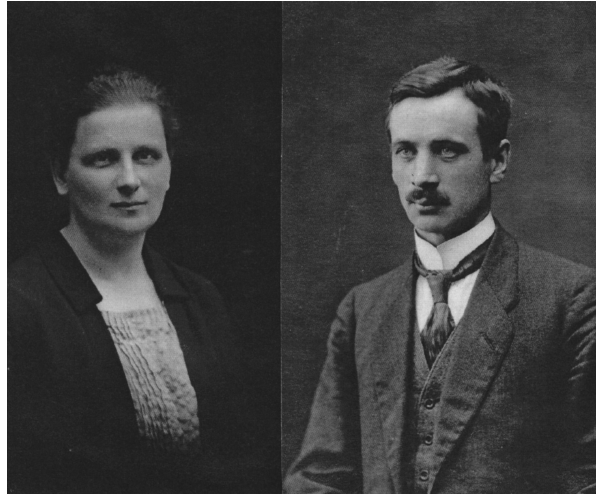
Figure 1. The couple, Siiri and Jaakko Keränen, photographed in around 1920. Jaakko was the first director of SGO, and Siiri was his assistant from 1913–1917. She made almost all the magnetic obser- vations and edited the annual reports. In the summertime, Jaakko was absent because he was doing fieldwork; meanwhile, Siiri acted as his deputy director (photo supplied by FMI).